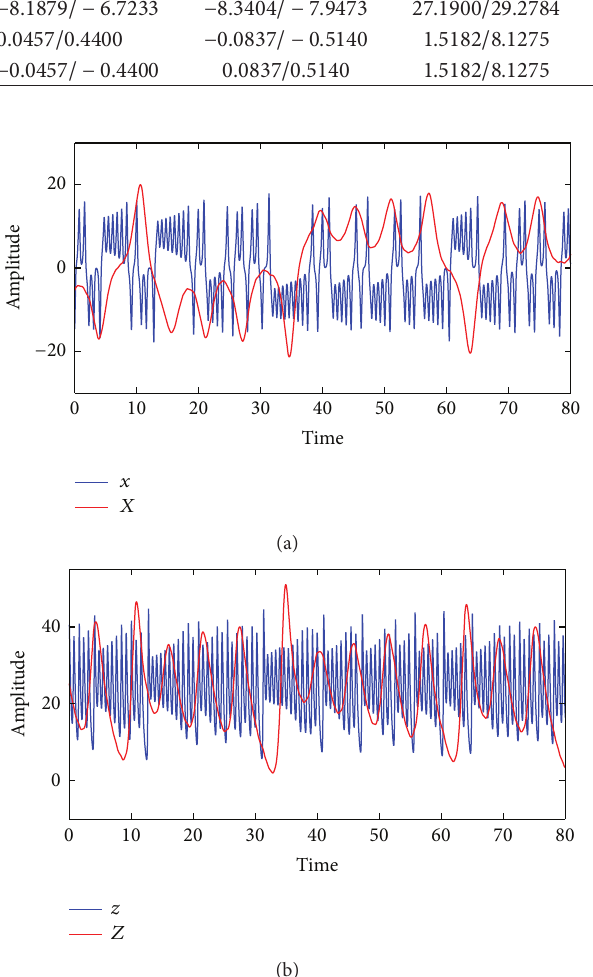
Figure 3: Time evolution of fast and slow dynamic variables for 𝑐 = 0.15